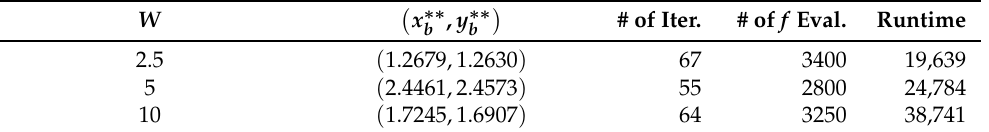
Table 5. The maximizers found by the GA and the runtimes, iteration counts, and numbers of function evaluations entailed by the GA for the case of a single helix and three sizes of the flow meter (7): W = 2.5, 5, and 10. (Forty-eight computer cores are used). (cid:0) (cid:1) W x ∗∗ , y ∗∗ # of Iter. # of f b b